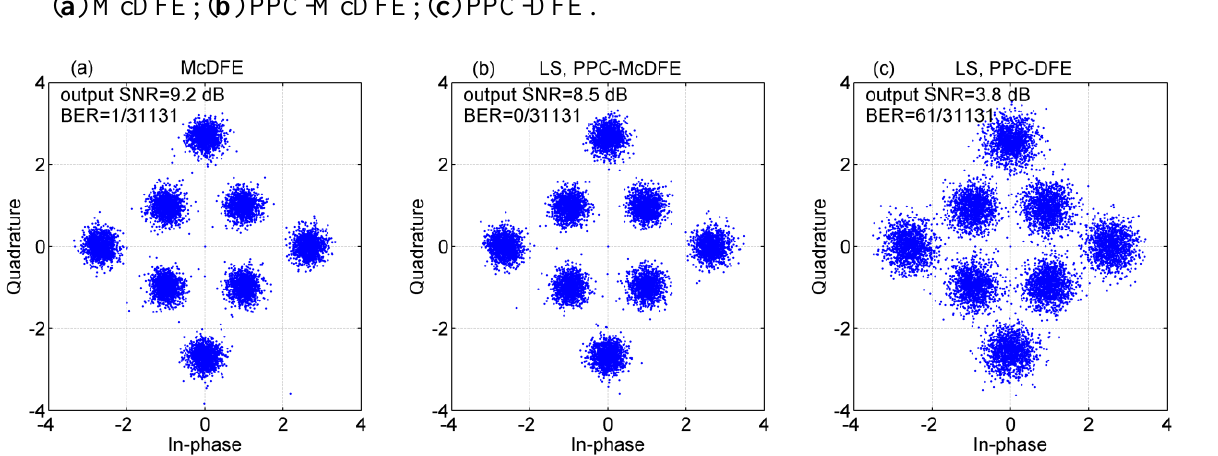
Figure 9. Scatter plot of estimated 8-QAM symbols using different receiver